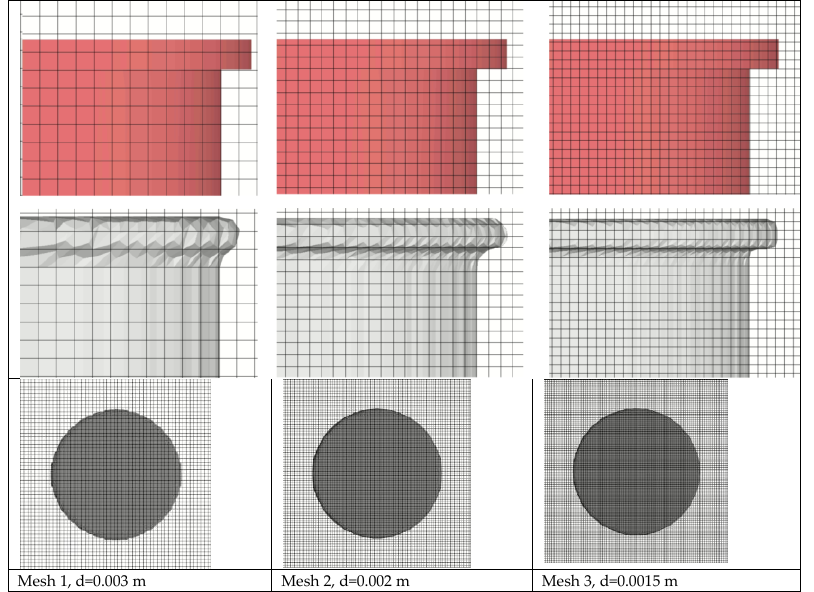
Figure 9. Structured mesh used in FLOW-3D and the FAVOR TM technique—the original shape of the rotor and the shape of the object after FAVOR discretization technique for 3 mesh densities.